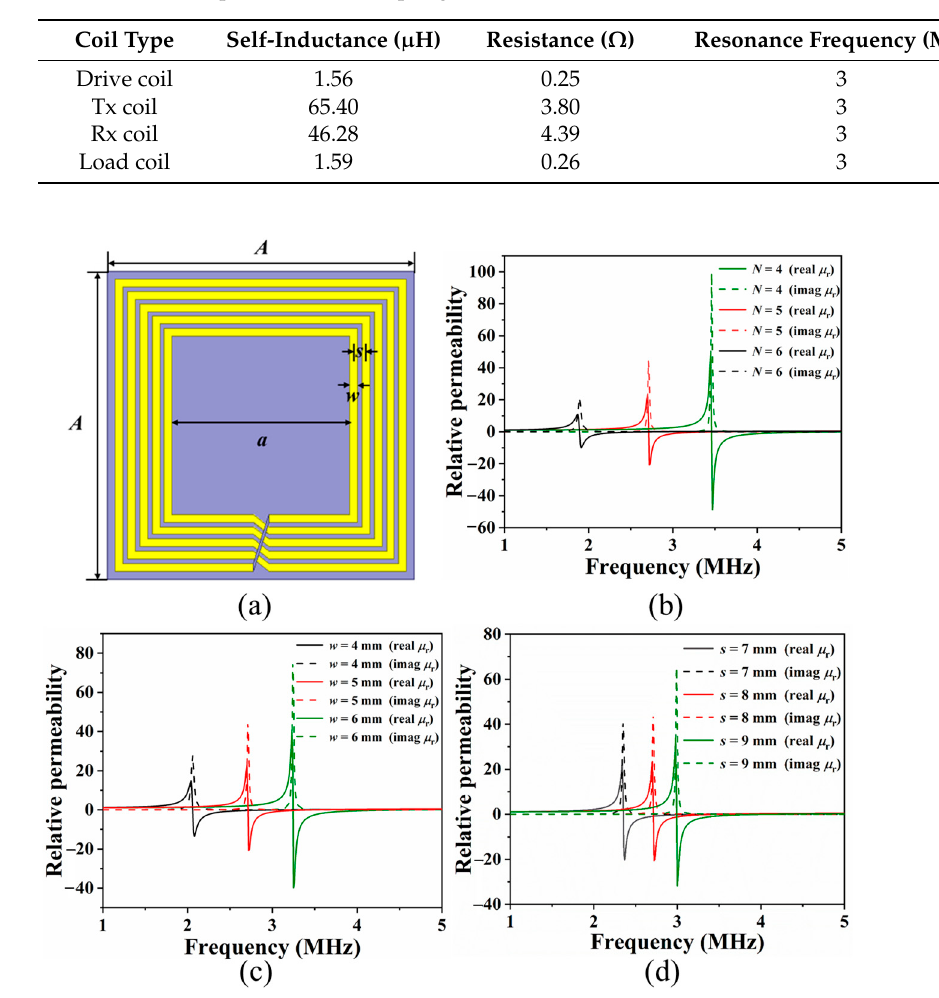
Figure 5. ( a ) The structure diagram of the MM unit cell. The relationship of relative permeability and resonance frequency depending on ( b ) the number of turns, ( c ) the width and ( d ) the spacing. Table 2. Parameters of the MM unit cell.